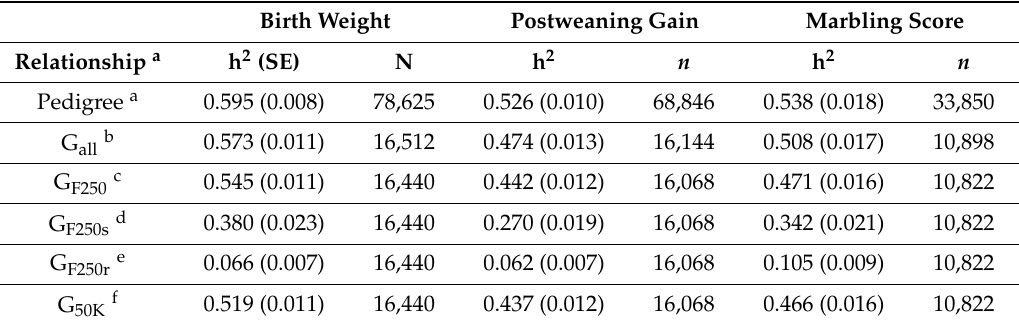
Table 4. Restricted maximum likelihood heritability (h 2 ) estimates for birth weight, postweaning gain, and marbling score using pedigree and di ff erent genomic relationship matrices. Birth Weight Postweaning Gain Marbling Score Relationship a